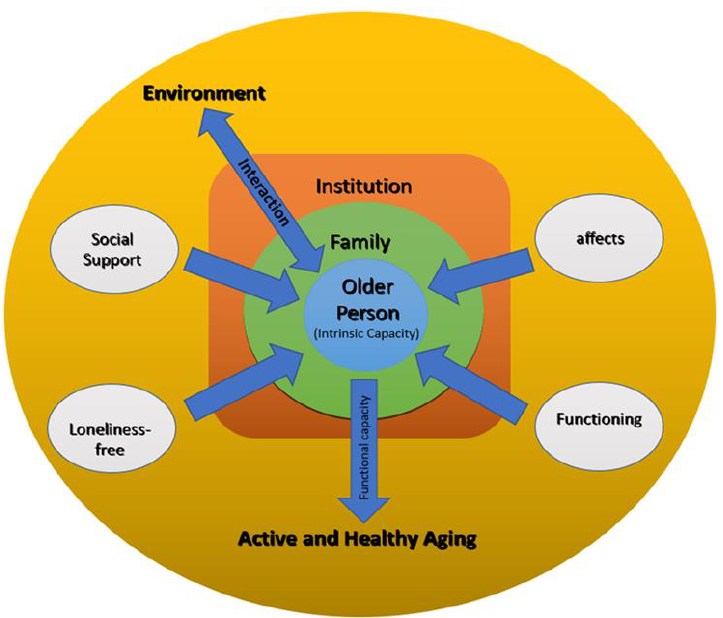
Figure 1. “Geriatric Proximity” intervention.